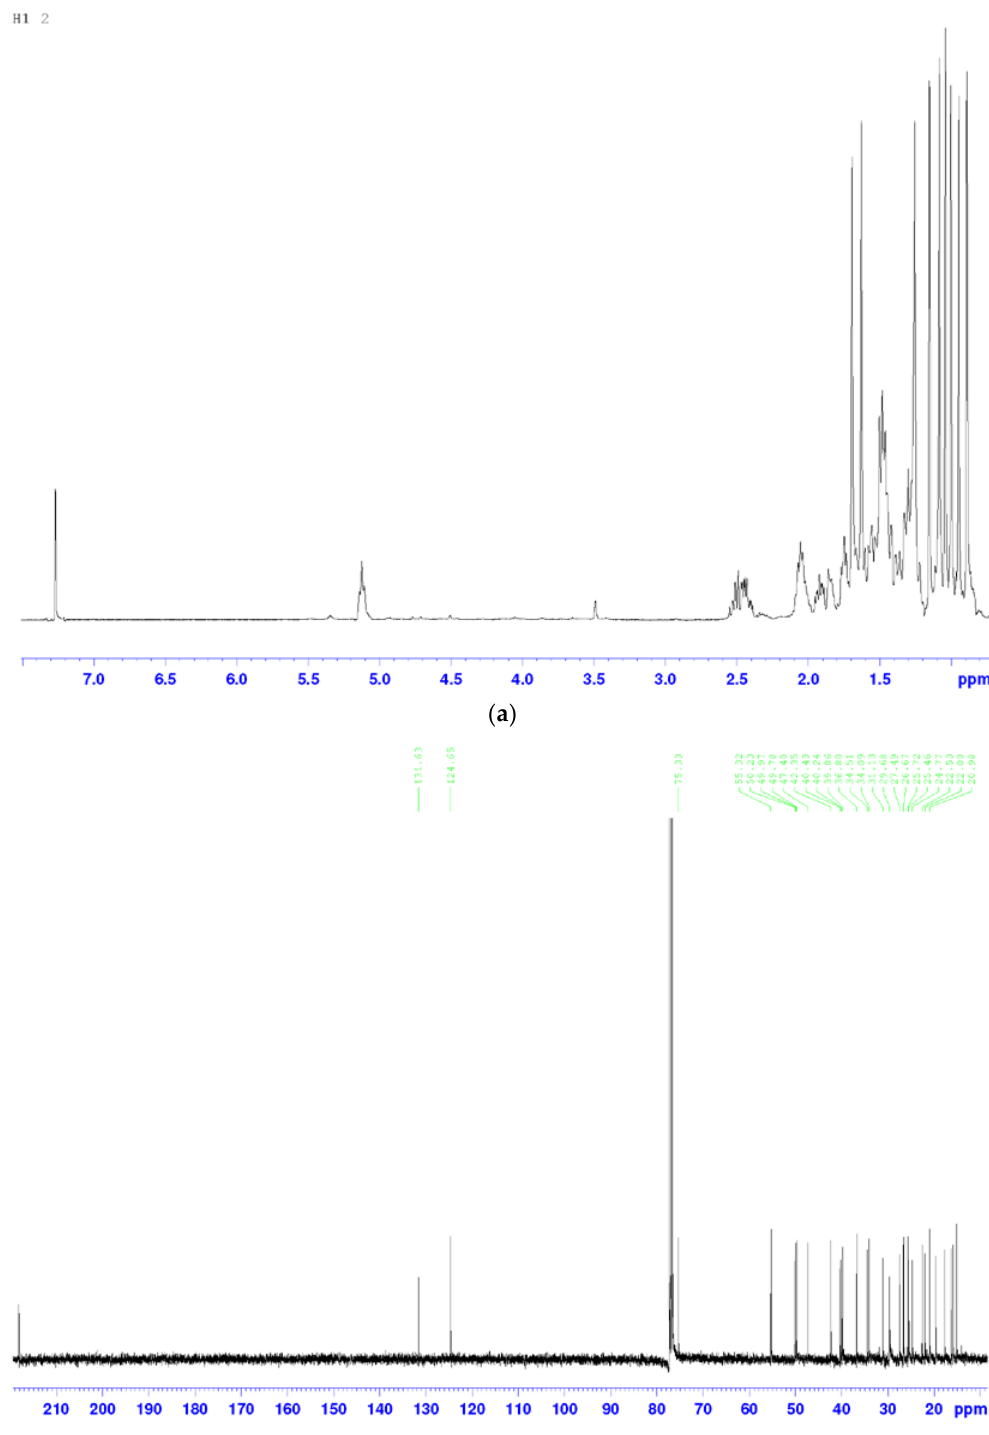
Figure 4. ( a ) 1 H-NMR and ( b ) 13 C-NMR spectral data of 20-hydroxy-24-dammaren-3-one.